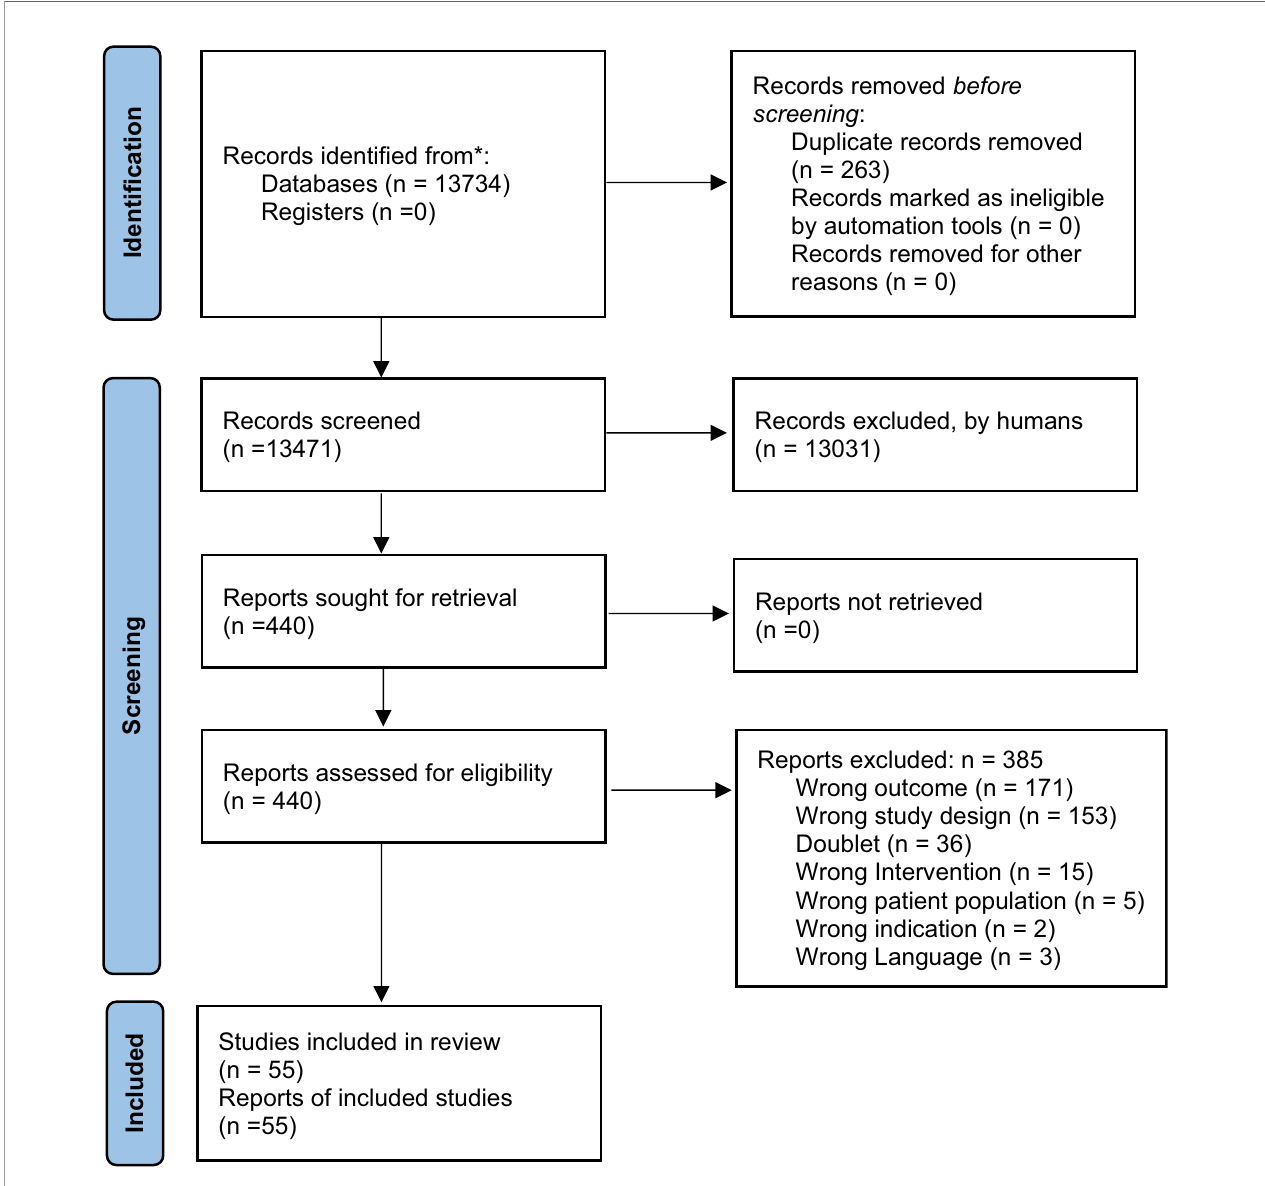
FIGURE 1 | Flowchart of literature search and study